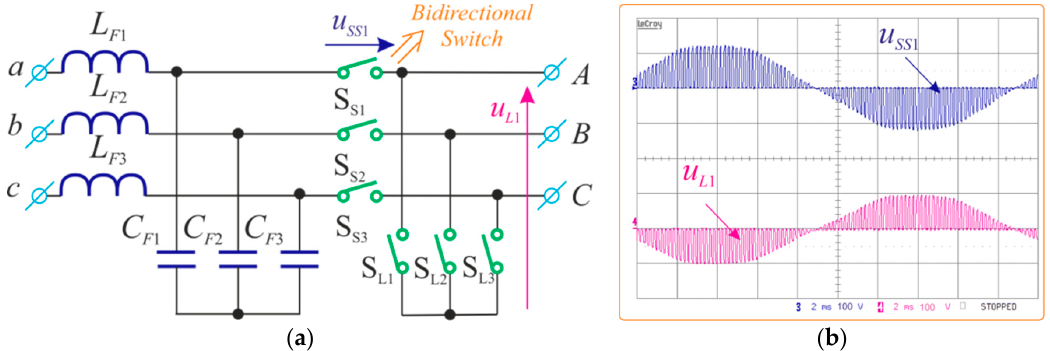
Figure 3. AC/AC controller: ( a ) main circuit; ( b ) voltage time waveforms. Figure 3. AC / AC controller: ( a ) main circuit; ( b ) voltage time